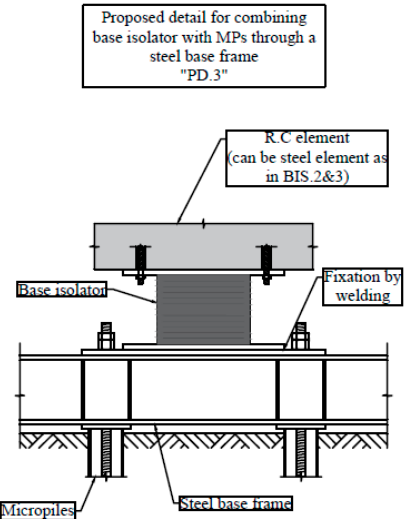
Figure 15. New proposed detail for combing MPs with BIS (new/existing reinforced concrete footing).